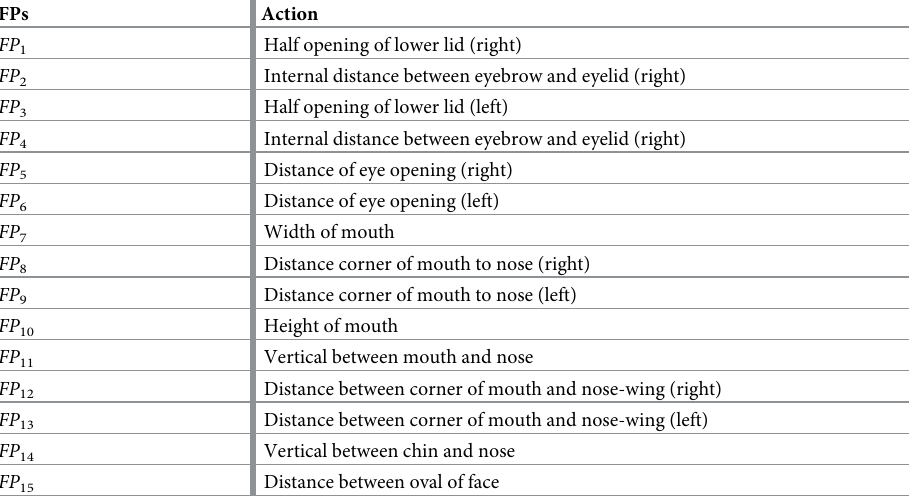
Table 1. Facial parameter